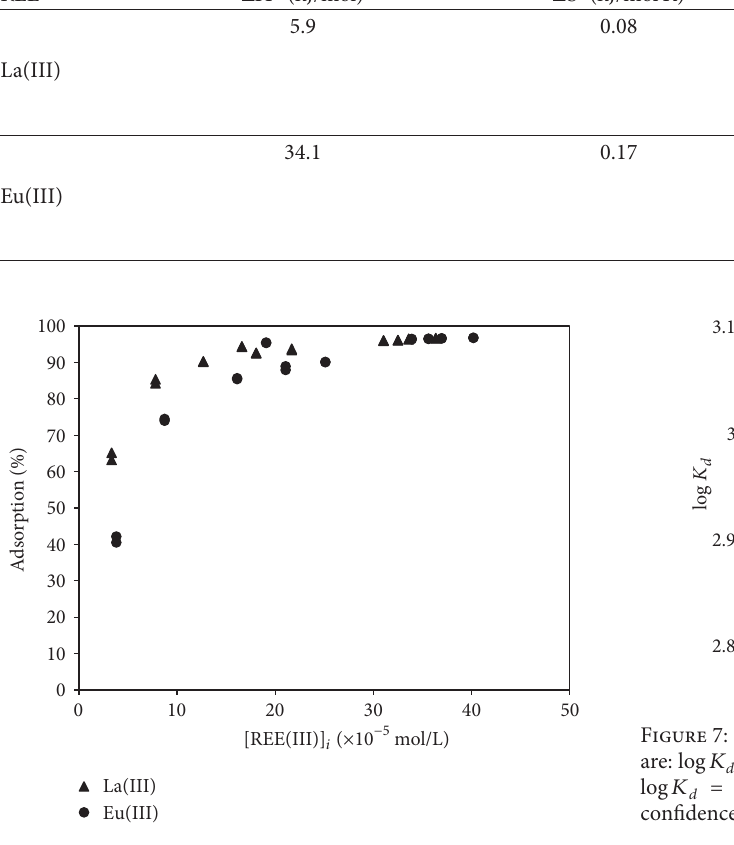
con�dence intervals of the regression lines are